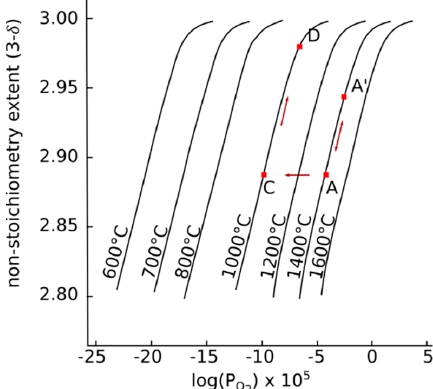
Figure 2 . Oxygen non-stoichiometry of La 0.6 Sr 0.4 MnO 3 as a function of the logarithm of oxygen partial partial pressure at different temperatures (adapted from Reference [23]). Pressure-swing